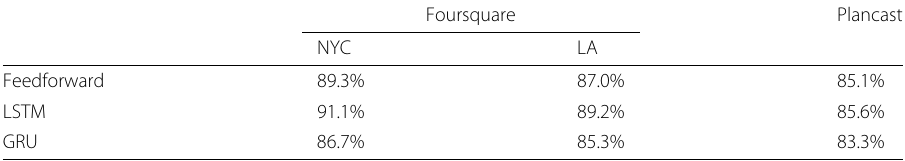
Table 5 Architecture performance in terms of accuracy: Feedforward vs. LSTM vs. GRU